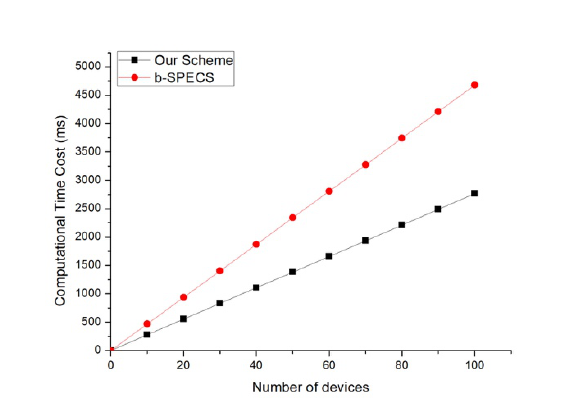
Figure 2. Computational cost in different number of